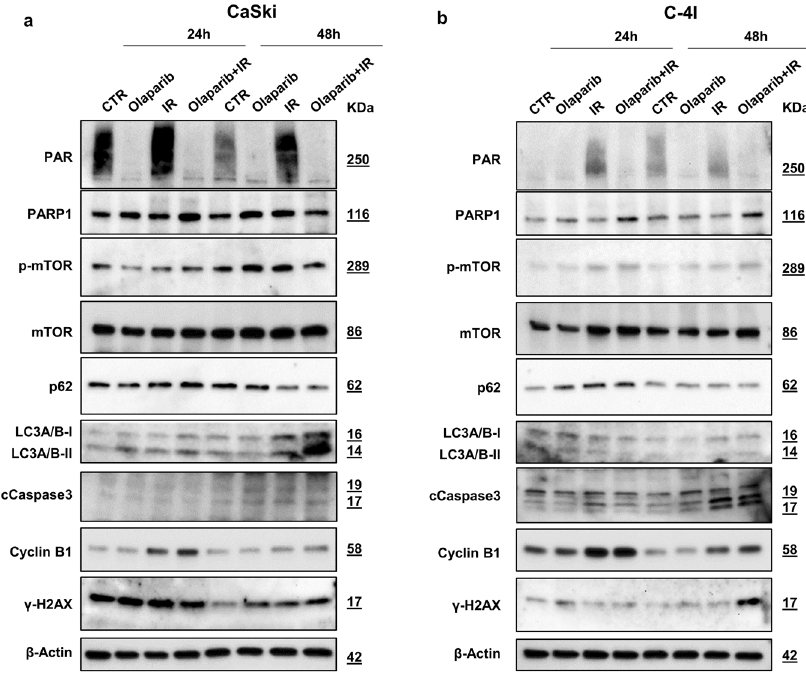
Fig. 5 Modulation of protein levels by Olaparib with or without IR in cervical cancer cells. a CaSki and b C-4I cells were pretreated for 1 h with Olaparib (0.7 µM) and then irradiated (2 Gy). Cells were harvested 24 or 48 h after treatment and whole-cell lysates (30 μ g) were loaded into SDS-PAGE, followed by Western blot with speci fi c antibodies. β -Actin was used as a loading control. CTR untreated; IR 2 Gy γ -rays. Data were representative of at least three